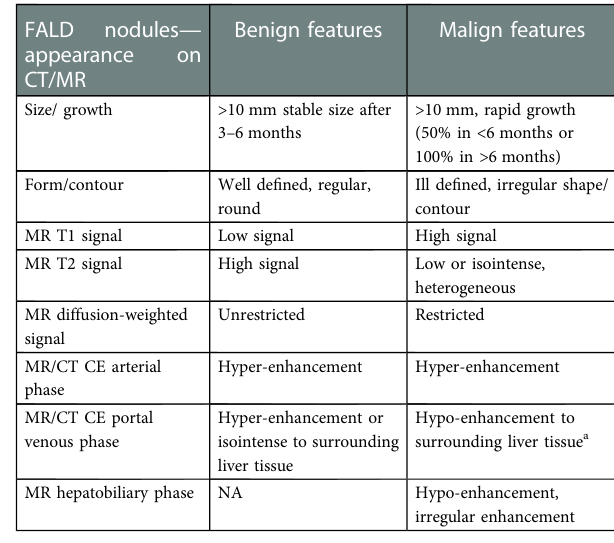
TABLE 2 Typical characteristics of benign and malign imaging features of nodules.